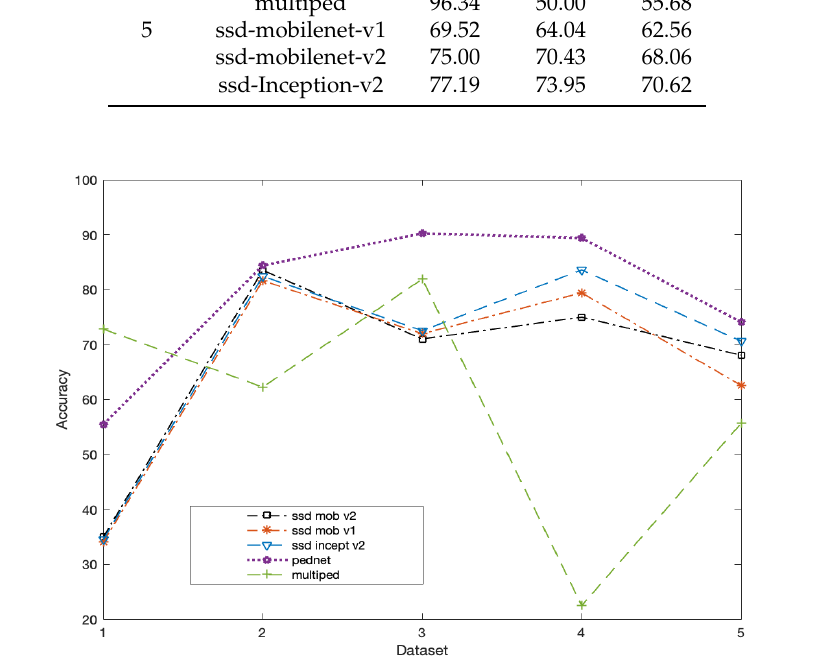
Figure 7. Accuracy pedestrian